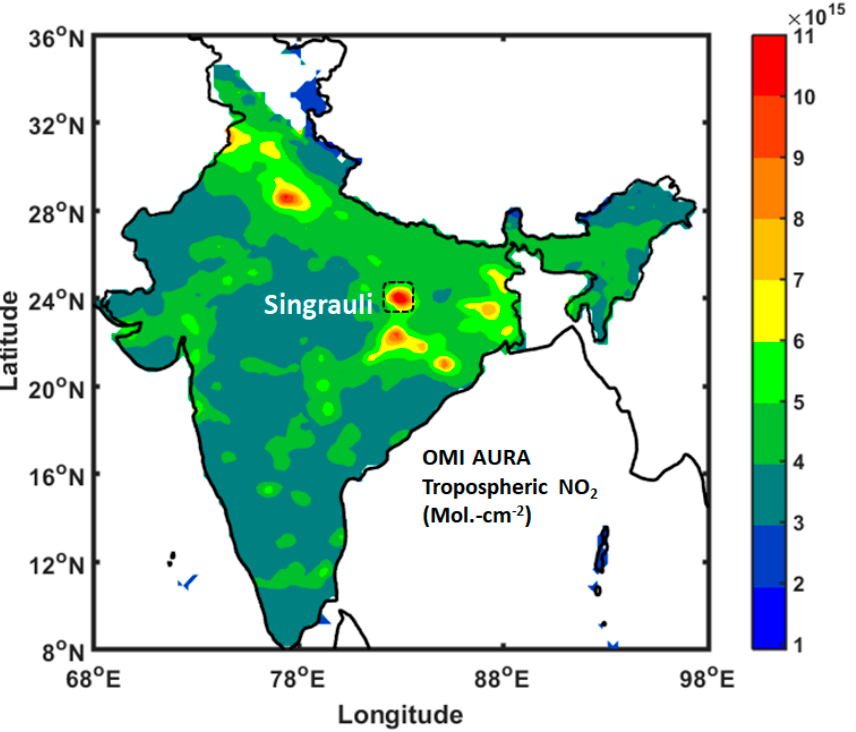
Figure 1. OMI derived average NO 2 concentration over Indian region (68–98° E, 8–36° N) for 1 January–31 March 2013; black rectangle area represents the Singrauli and surrounding